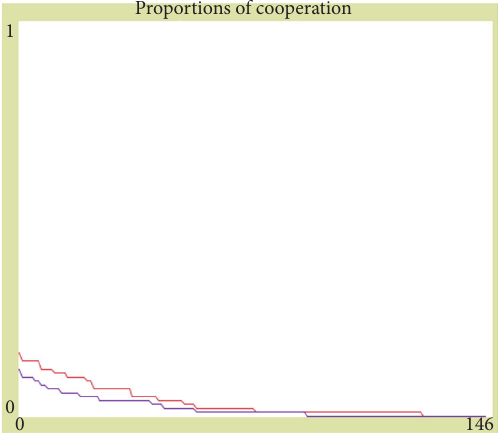
Figure 9: Simulation on calmness of knowledge workers’ CWB. Figure 10: Simulation on neuroticism of knowledge workers’